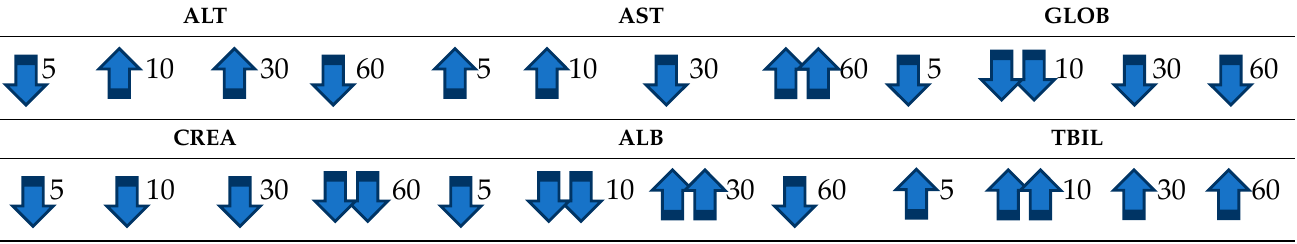
Table 3. Levels of biochemical enzymes in the blood of mice treated with gold nanoparticles for 28 days at a dose of 4000 μ g/kg. ALT—alanine transaminase, AST—aspartate transaminase, GLOB—globulin, CREA—creatinine, ALB—albumin, TBIL—total bilirubin. ↑↑ —largest increase, ↑ —increase, decrease, ↓↓ —largest decrease. ALT AST ALT AST GLOB